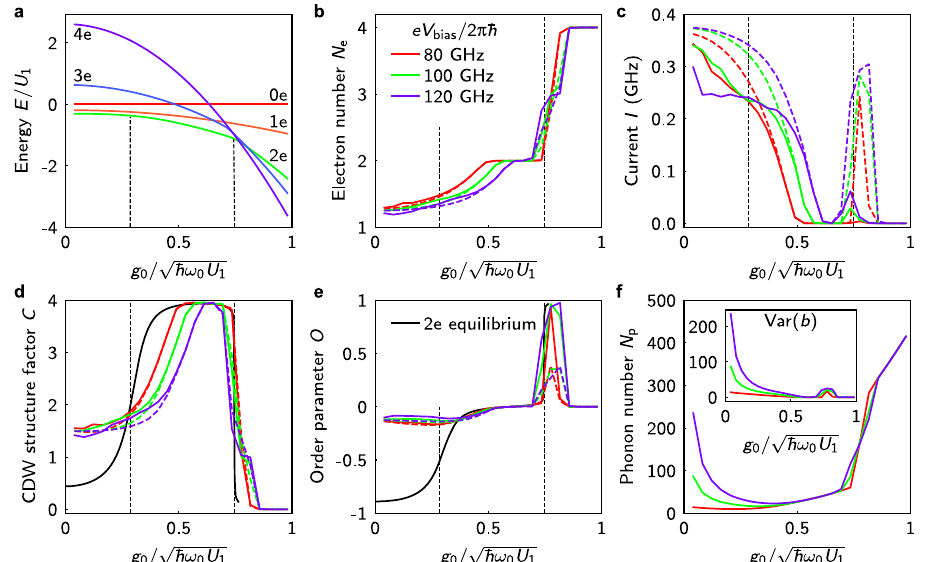
Fig. 3 Phonon-induced transport behavior. a Lowest energies of the system in different electron number sectors. Upon increasing the electron-phonon coupling g 0 , the electron number of ground state changes from two electrons to four electrons for the chosen local chemical potential ε /2 π ℏ = − 30 GHz. b – e Electron number N e , current I , CDW structure factor C , and order parameter O in the steady state for various V bias obtained from the Pauli master equation (dashed lines) and shift method without updating the shift parameter (solid lines); see “ Methods ” . In d and e , we also plot the CDW structure factor C and order parameter O of equilibrium two-electron states (black lines) for the convenience of comparison. The black dashed vertical lines in a – e label the approximate transition points in the two-electron sector identi fi ed from the equilibrium CDW structure factor and order parameter. f Phonon number N p obtained from the Pauli master equation. The insert shows the variance of phonon operator, Var( b ). Here we truncate the phononic Hilbert space to a fi nite-dimensional Hilbert space with maximal 1000 phonons for the Pauli master equation. The shift method for eV bias /2 π ℏ = 80, 100, and 120 GHz is performed within a Hilbert space with maximal 40, 45, and 50 tilded phonons, respectively. Other parameters are t 0 /2 π ℏ = 5 GHz, U 1 /2 π ℏ = 200 GHz, U 2 /2 π ℏ = 20 GHz, U 3 /2 π ℏ = 2 GHz, ω 0 /2 π = 3 GHz, Γ /2 π ℏ = 1 GHz, and k B T /2 π ℏ = 2